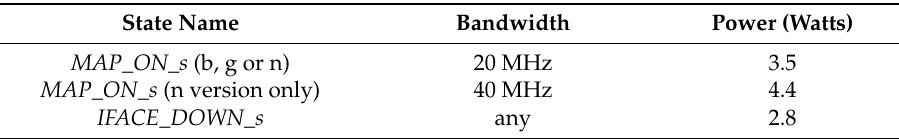
Table 2. Consumption measurements for the WRT160NL